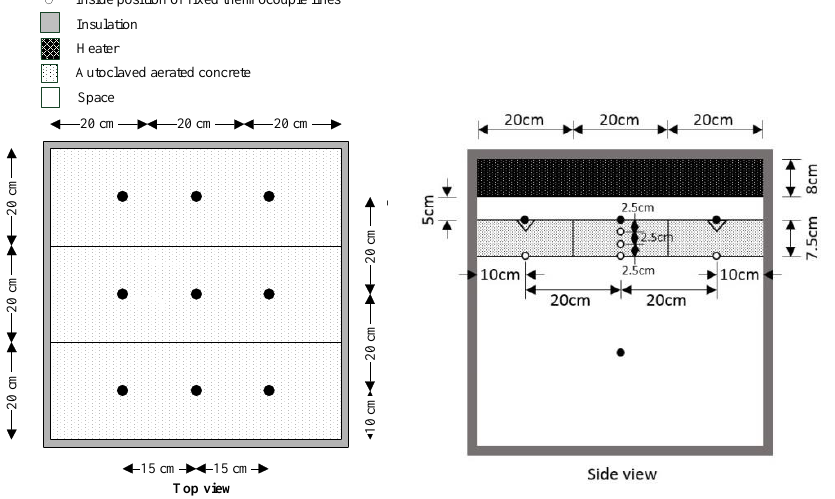
Figure 2. Fixed locations of thermal couples set for testing the time lag and decrement factor of samples.